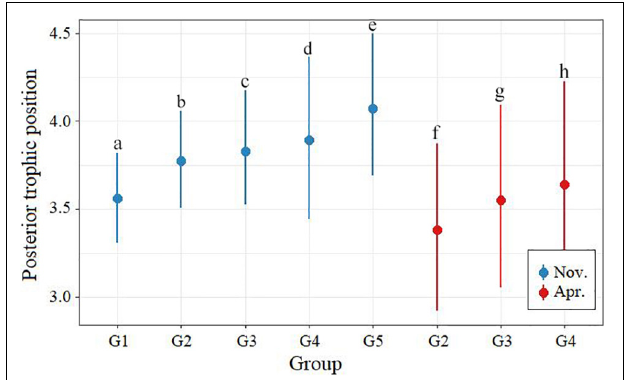
FIGURE 5 | Different body size groups’ modal trophic position of Bombay duck in November (blue circles) and April (red circles) with their associated 95% credibility intervals based on posterior probability distributions. Different letters indicate significant differences in each